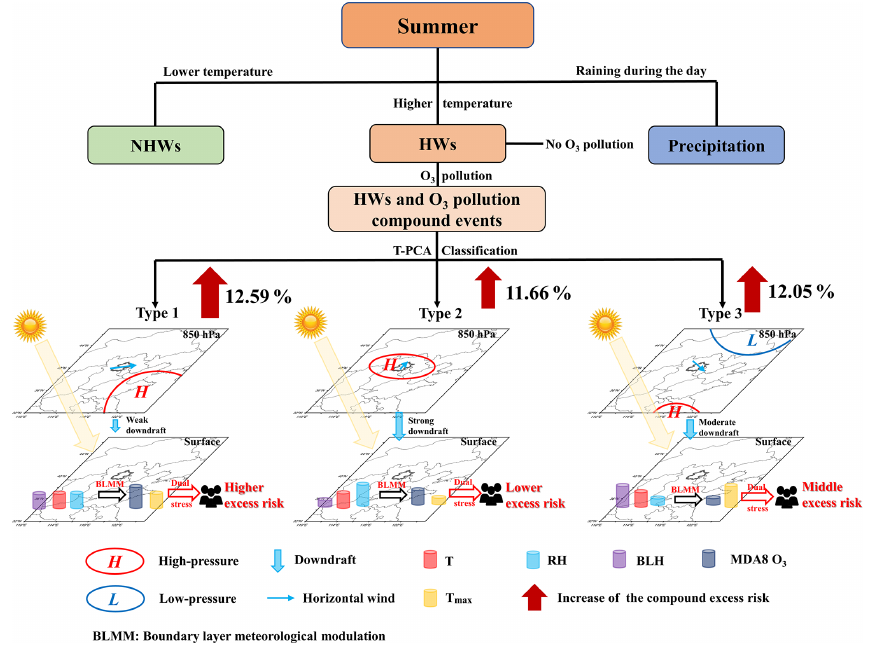
Figure 8. Schematic illustration of the mechanism of HW and O 3 compound pollution events under different synoptic weather patterns (height of the icon indicates the size of each